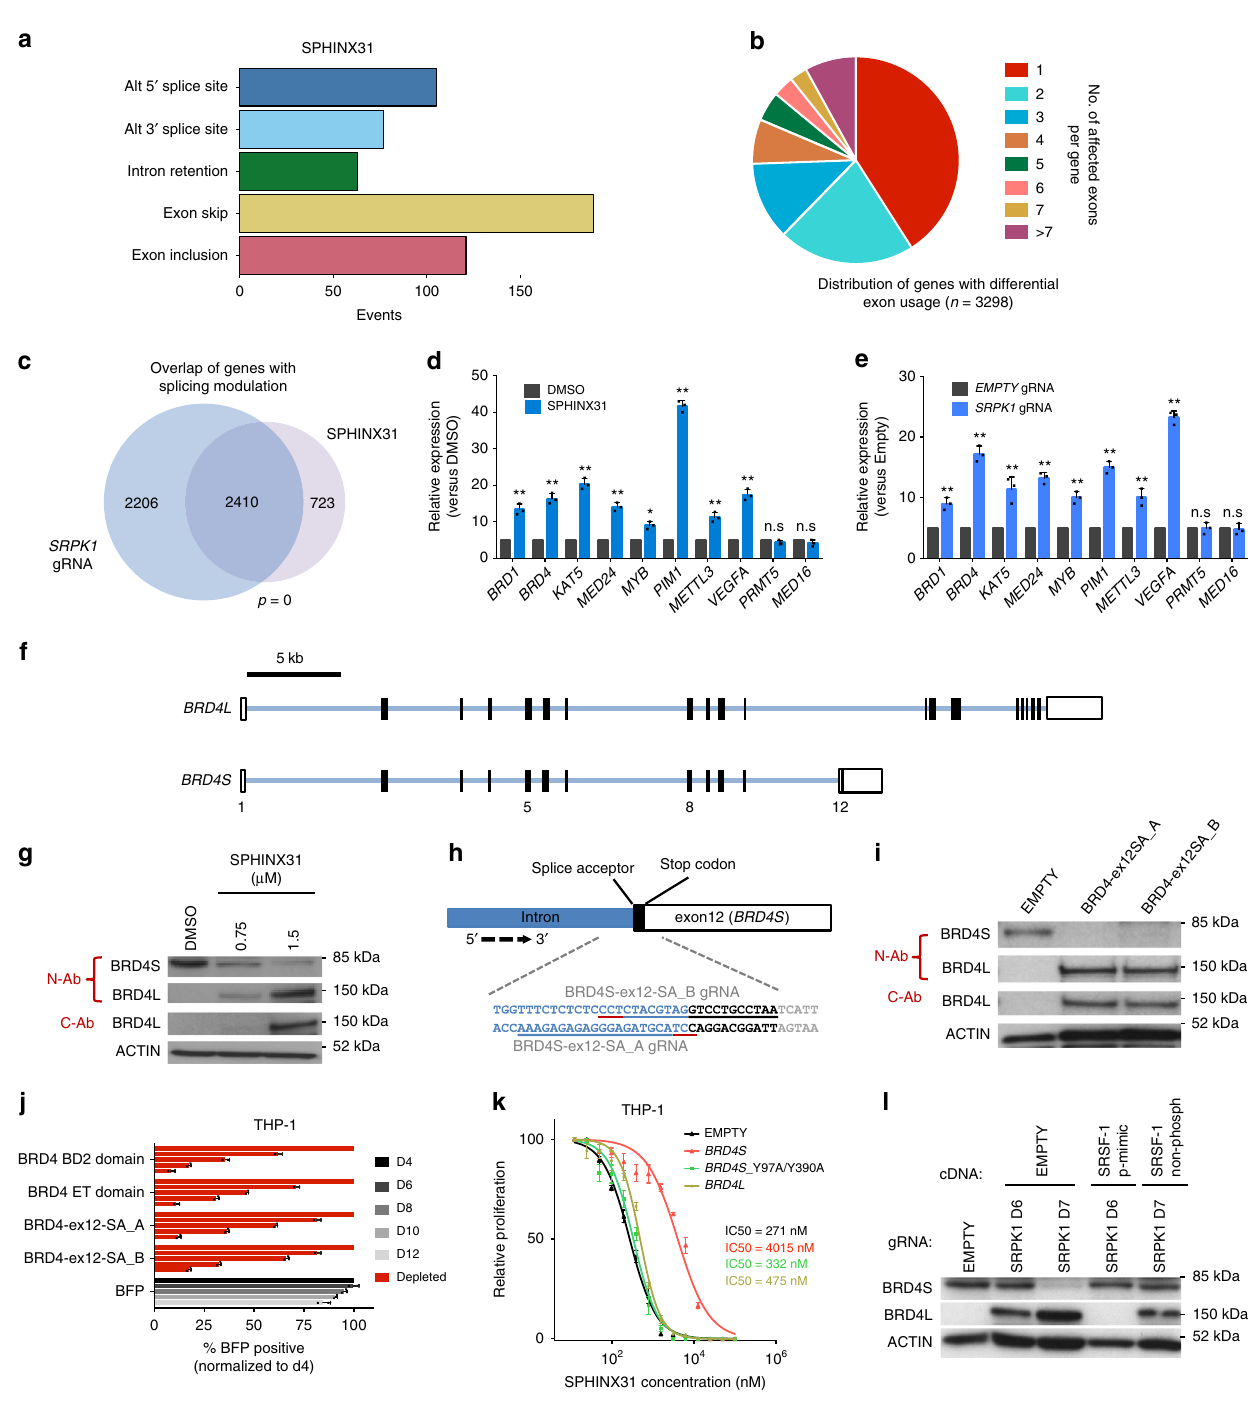
xenotransplantation model and found strong synergy, with signi fi cant deceleration of AML growth and prolongation of mouse survival (Fig. 4j, k, Supplementary Fig. 11c), without noticeable toxicity. We also performed the same experiments using the MLL-WT HEL cells and did not observe any synergistic effect either in vitro or in vivo (Supplementary Fig. 11d – f).